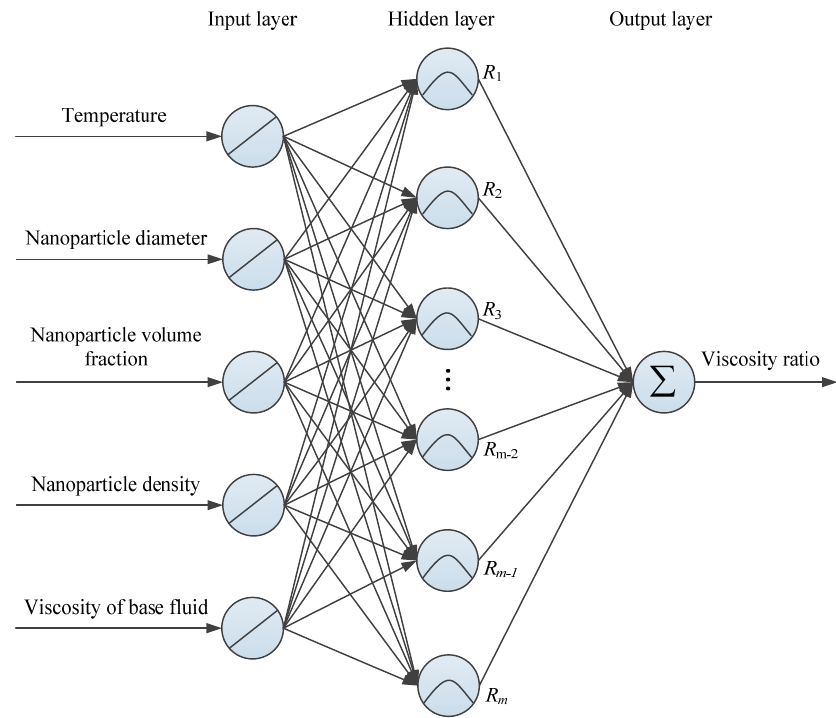
Figure 3. RBF neural network developed in this study.